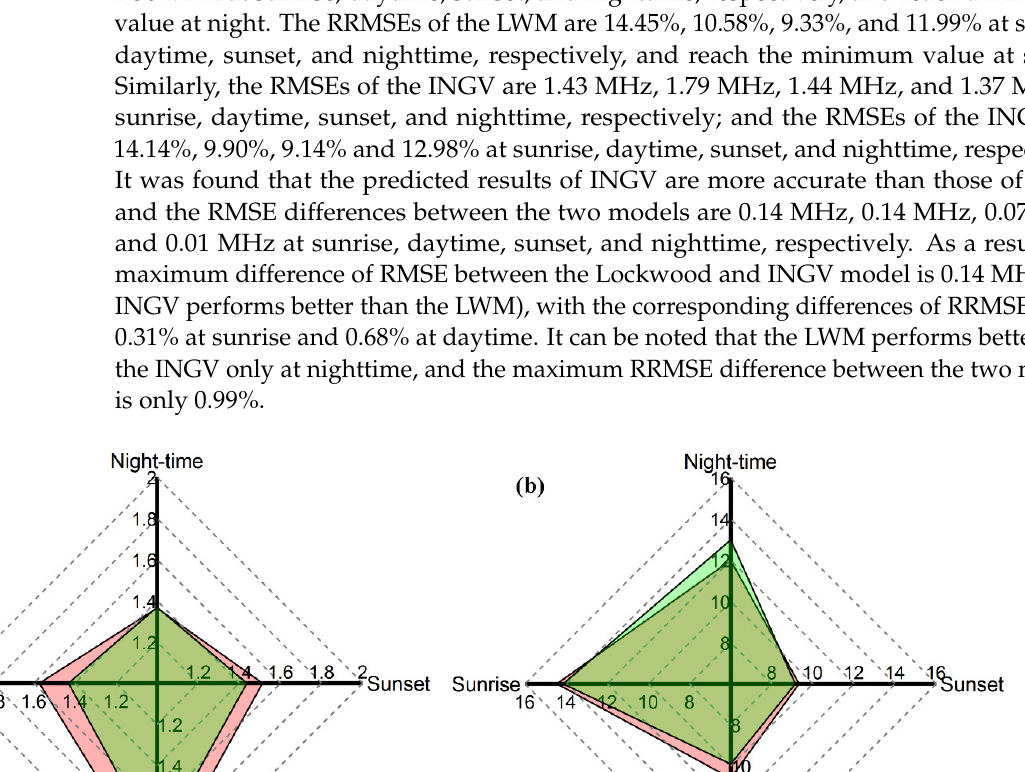
Figure 6. The seasonal behavior of MUF calculated by the LWM and INGV: ( a ) RMSE; ( b ) RRMSE.